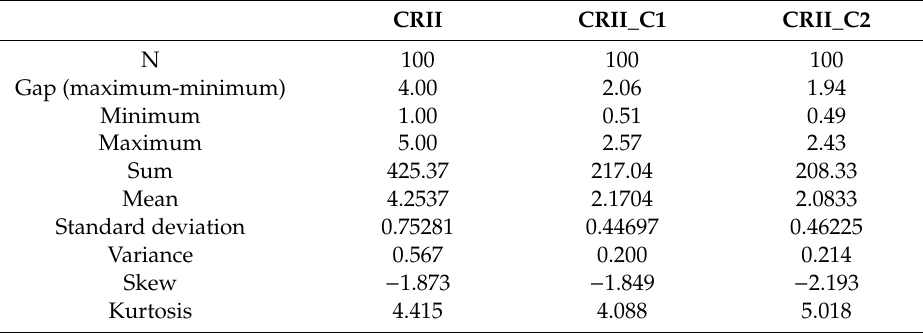
Table 27. Friedman’s test—for two components of CRII .